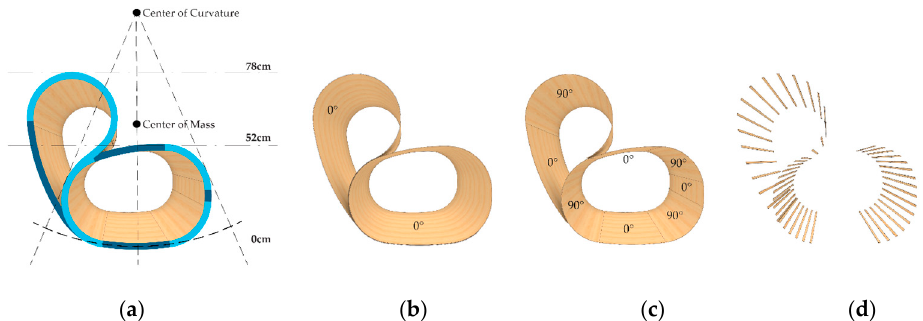
Figure 21. Timber lamination of final prototype: ( a ) complete timber lamination according to the geometric constraints of a rocking chair and timber bending limits; ( b ) first lamination layer with continuous 0-degree veneer; ( c ) second lamination layer with mixed 0-degree and 90-degree veneer; ( d ) laminated anchor teeth.